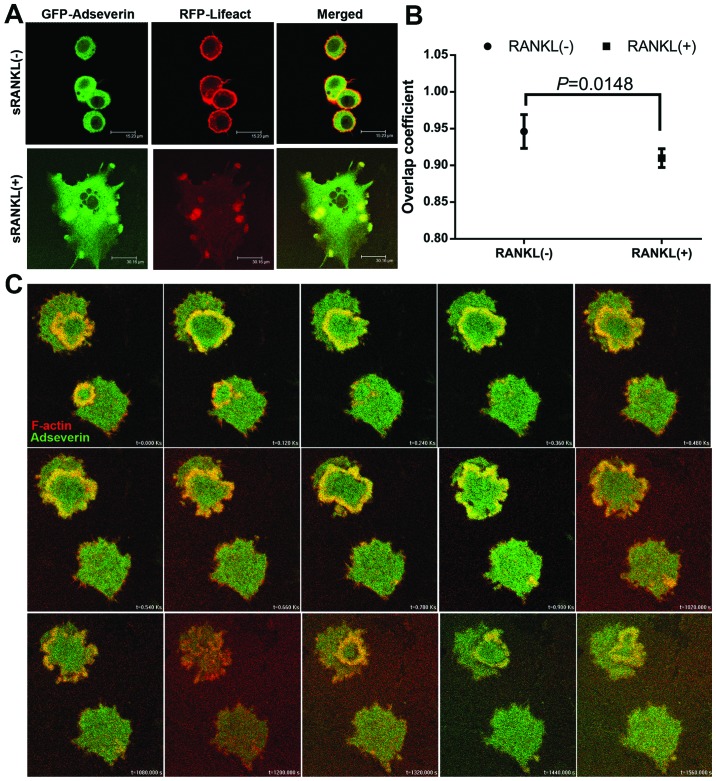
Immunofluorescence images of adseverin (Ads) (green) and F-actin (red) proteins in RAW264.7 cells following sRANKL administration. (A) Ads and F-actin colocalization is shown by the overlap of signals, resulting in yellow staining. In unstimulated RAW264.7 cells, F-actin and Ads colocalized in continuous and intense rings of fluorescence at the subplasmalemmal region. Upon sRANKL stimulation for 3 days, cortical F-actin and Ads rings are disrupted at the periphery with dot-like podosome structures, suggesting redistribution of Ads and F-actin disassembly during osteoclastogenesis. (B) Colocalized pixels of yellow color are located along the diagonal of the scattergram. Scatterplots showed that the Ads and F-actin overlap coefficient decreased from 0.94 (without sRANKL) to 0.91 (with sRANKL) (n=5). (C) Time-lapse confocal microscopy video frame shows Ads and F-actin colocalized in actin rings, actin ring assembly and disassembly during filming in mature OCs, indicating that Ads plays a role in actin assembly and cytoskeleton regulation. RANKL, receptor activator of nuclear factor-κB ligand.